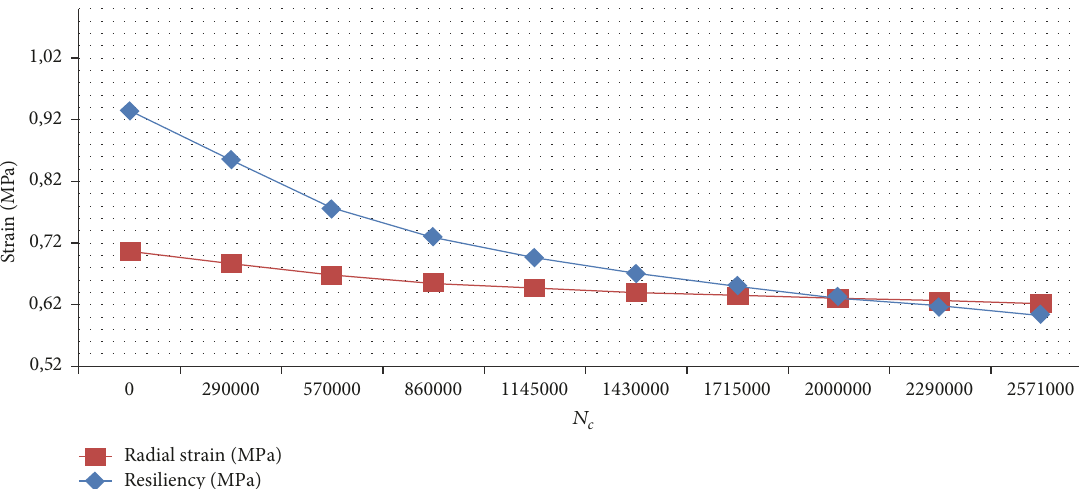
Figure 3: Relationship between stress in ACM depending on repeated loading and decrease of ACM strength resiliency depending on the fatigue trend function.